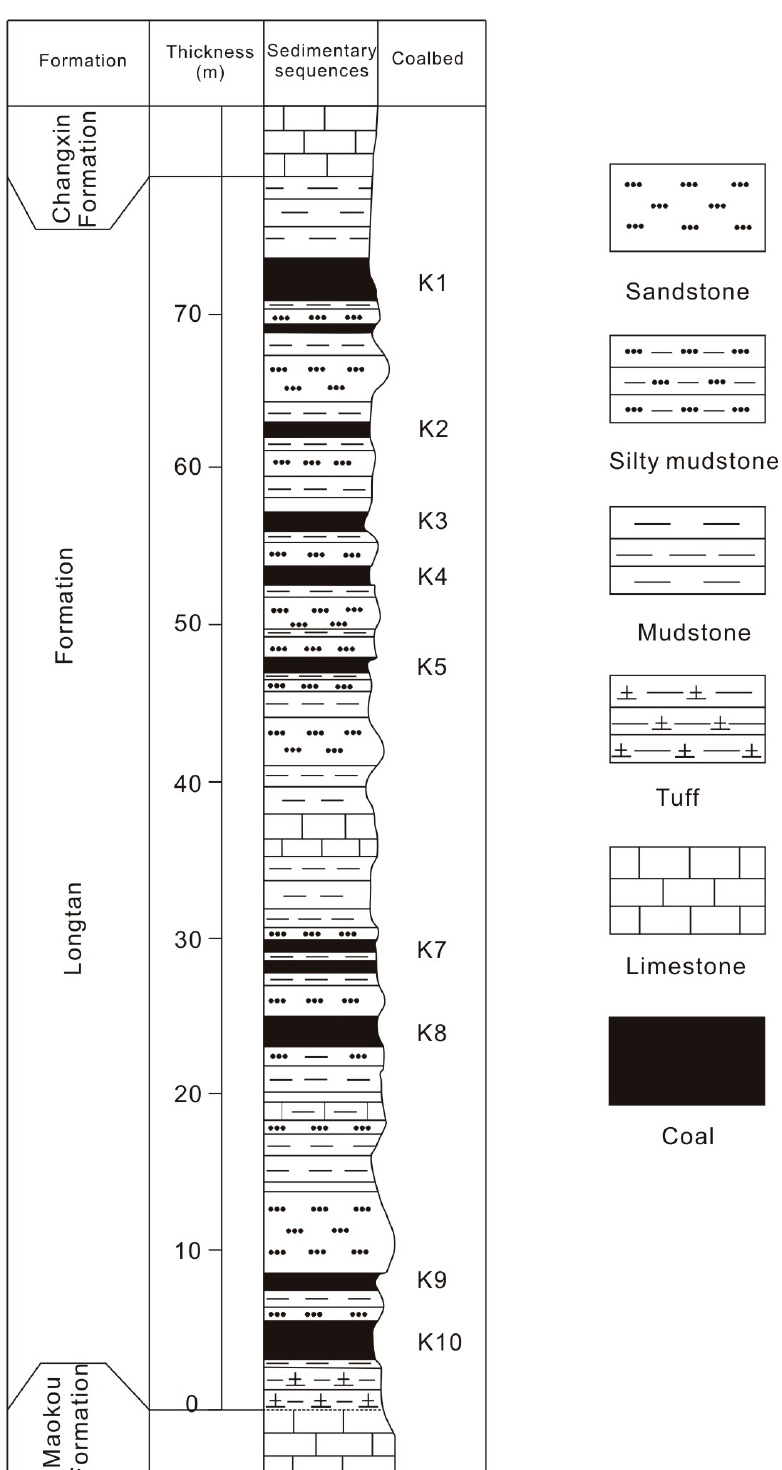
Figure 2. Generalized sedimentary sequence at the Zhongliangshan Mine, Chongqing. Percentages of major element oxides including SiO 2 , TiO 2 , Al 2 O 3 , Fe 2 O 3 , MnO, MgO, CaO, Na 2 O, K 2 O, and P 2 O 5 in the tuff samples were determined by X-ray fluorescence spectrometry (XRF) in Chongqing Institute of Geology and Mineral Resources. The contents of trace elements were determined by inductively coupled mass spectrometry (Thermo X series II ICP-MS,